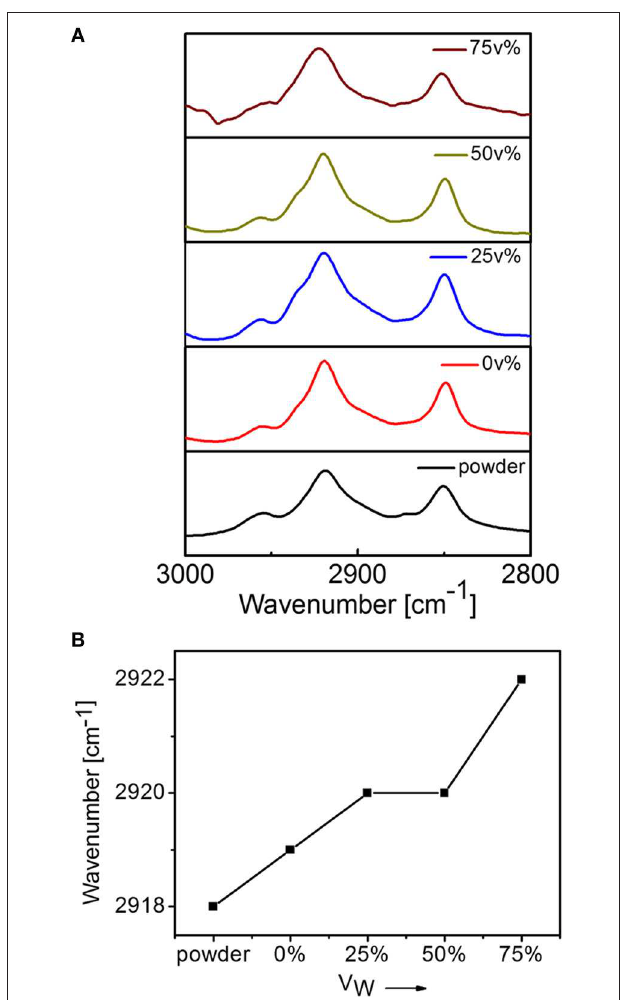
FIGURE 3 | (A) FT-IT spectra of DUO-TDI in solutions with variable V w (0, 25, 50, and 75 v%). (B) Variation of peak positions of asymmetric stretching vibration of CH 2